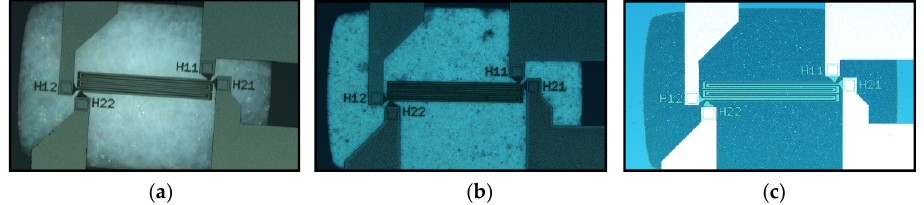
Figure 10. Topside micrographs of the PowderMEMS-modified devices. The solid porous microstructures are visible through the optically transparent membrane stack. ( a ) AP 300/30. ( b ) Silicon nitride. ( c ) Glassy carbon.